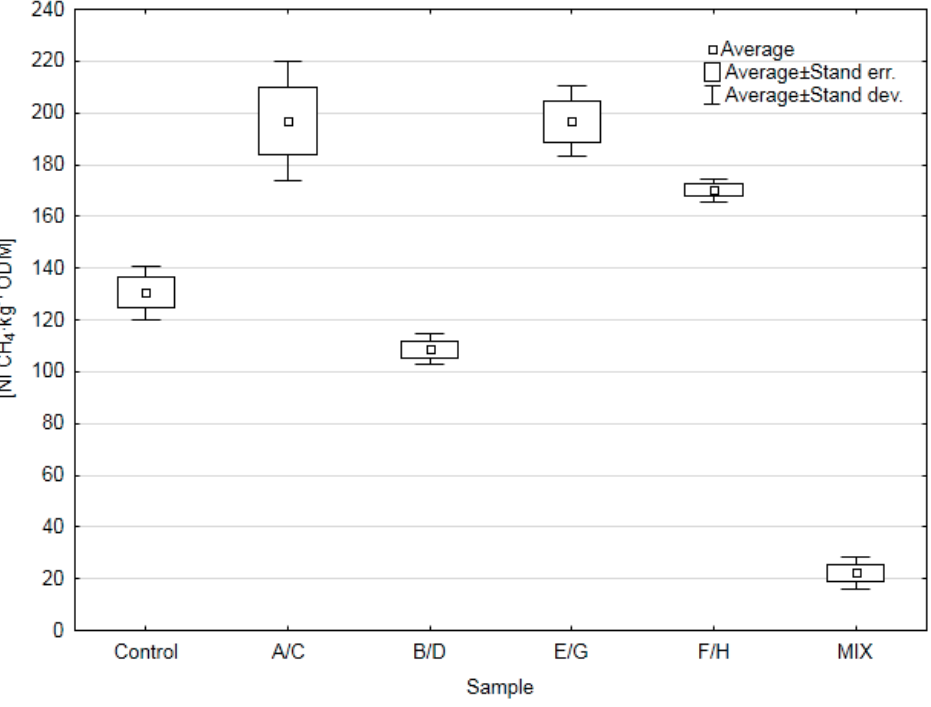
Table 2. Physicochemical parameters of substrates used for the experiment and achieved fermented material.